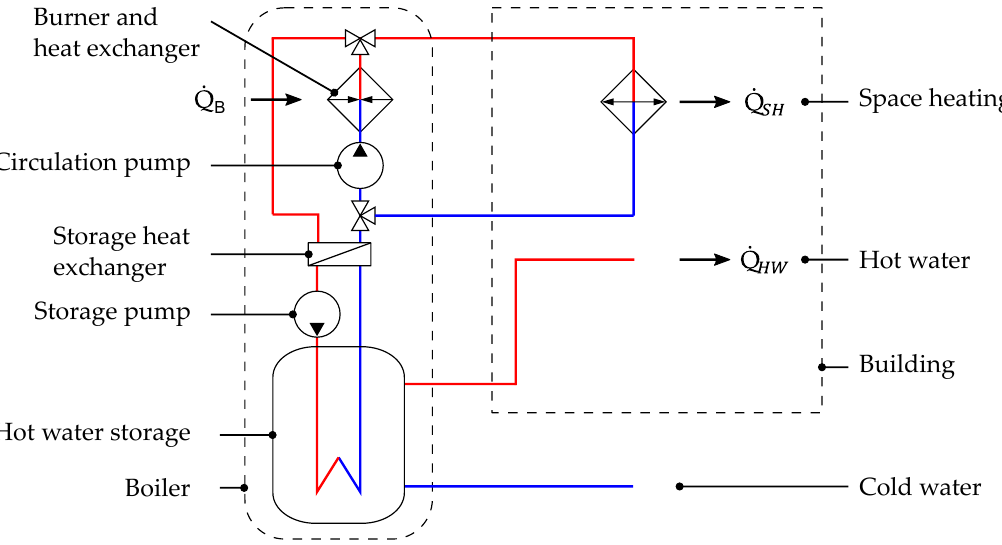
Figure 4. Schematic view of the modeled building energy system. It depicts the analyzed boiler in a typical detached house.